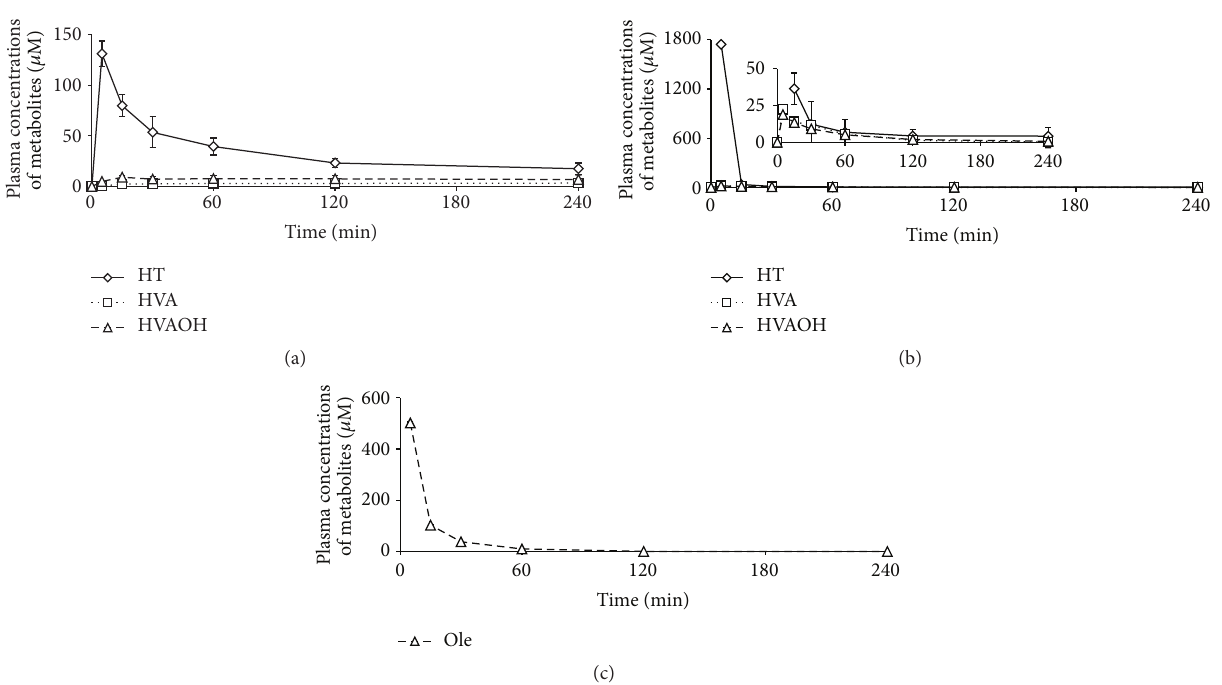
Figure 2: Metabolites from 3,4-DHPEA-EDA (a), hydroxytyrosol (b), and oleuropein (c) in plasma from the jugular vein over time after intravenous administration. Values of means and SEM are from measurements performed in triplicate. Analytical times are described in the text. HT: hydroxytyrosol, Ole: oleuropein, HVA: homovanillic acid, and HVAOH: homovanillyl alcohol.